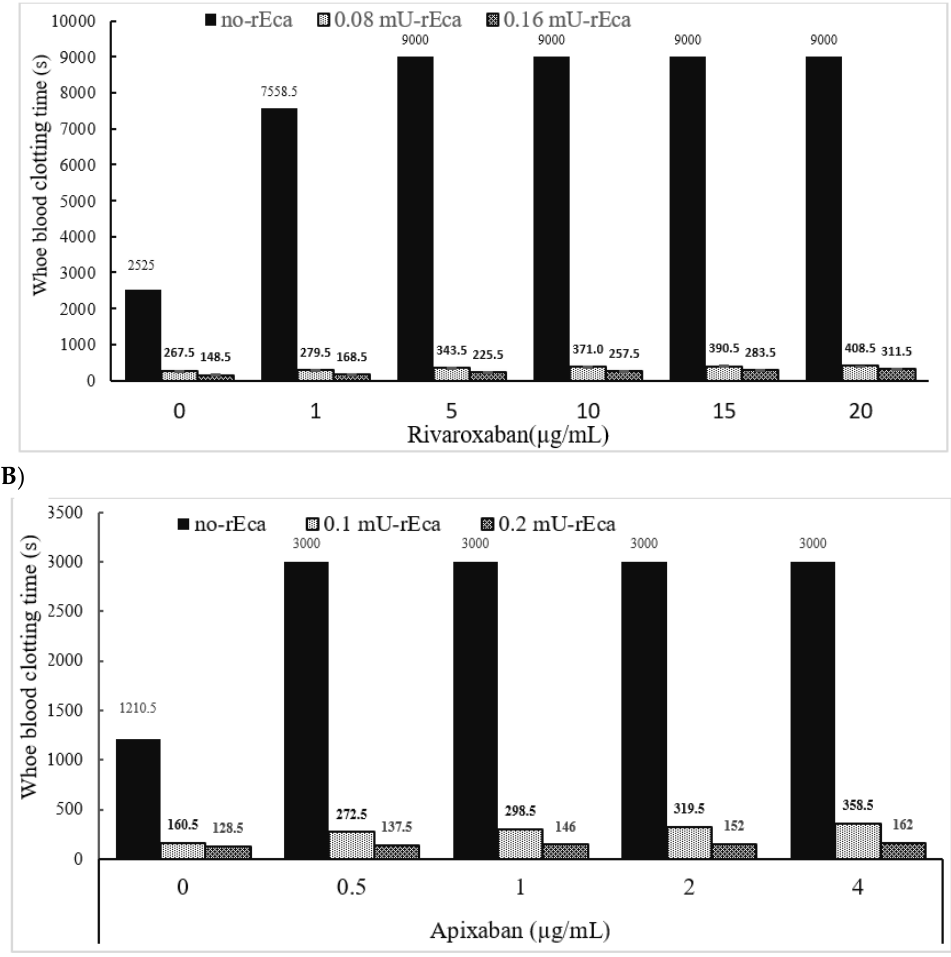
Figure 6. rEcarin effectively clots blood spiked with three anti-coagulants. The activity of rEcarin when clotting recalcified whole blood spiked with three different anti-coagulants (Arixtra, Rivaroxaban and Apixaban). ( A ) Time taken by rEcarin to clot recalcified whole blood spiked with Arixtra. * Blood containing 4 µg/mL of Arixtra or more did not clot without the supplementation of rEcarin. ( B ) Time taken by rEcarin to clot recalcified whole blood spiked with rivaroxaban. * Blood containing 0.5 µg/mL of Apixaban or more did not clot without the supplementation of rEcarin. ( C ). Time taken by RAPClot to clot recalcified whole blood spiked with Apixaban rivaroxaban. * Blood containing 5 µg/mL of rivaroxaban or more did not clot without the supplementation of rEcarin. The data are the mean of duplicate assays.